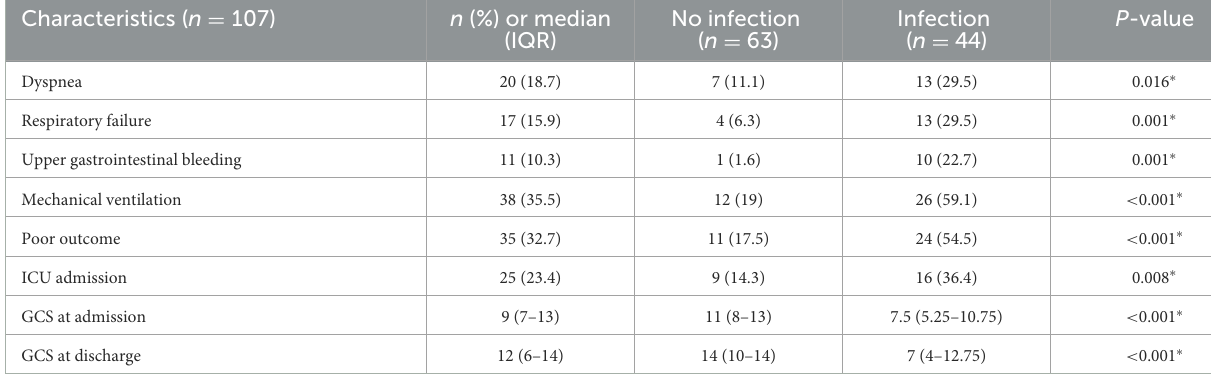
TABLE 2 Clinical characteristics were recorded in both groups with pulmonary infection and without pulmonary infection.